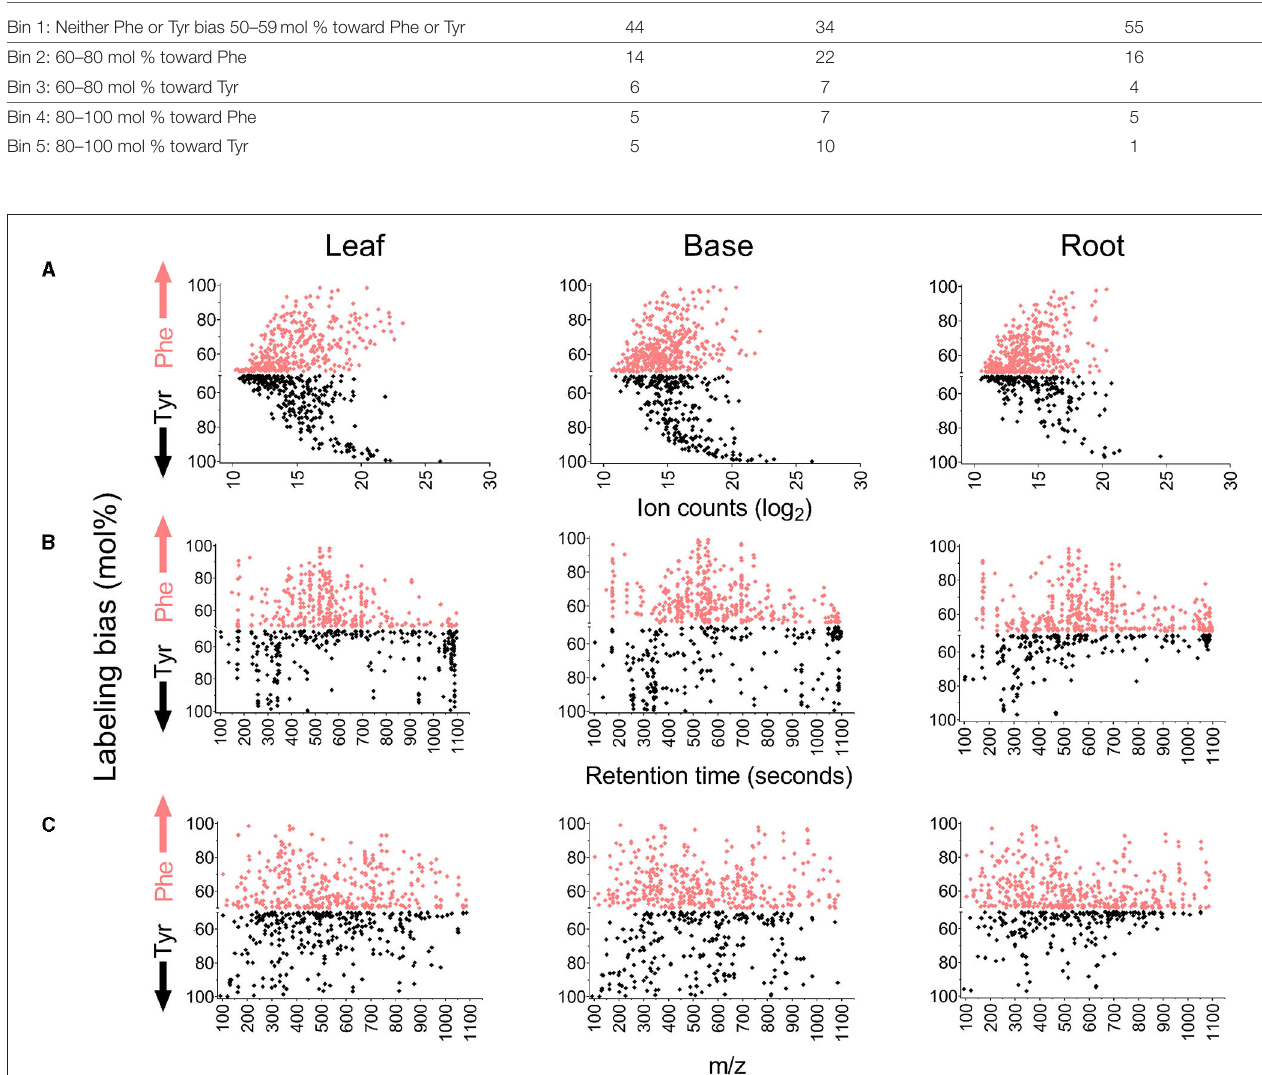
FIGURE 5 | Comparison of properties of metabolite features based on their incorporation of 13 C Phe or 13 C Tyr. The y-axis on each graph reports mol% labeling from Phe or Tyr if the bias toward an amino acid was above 50%. Features that fall above the middle axis were more heavily derived from Phe, and features that fall below were more heavily derived from Tyr. For example, an MS feature with a 90 mol% labeling from Phe and 10 mol% labelings from Tyr will be represented on the y-axis by a single point at 90 in the Phe-bias portion of the graph. On the contrary, an MS feature with a 10 mol% labeling from Phe and a 90 mol% labeling from Tyr will be represented by 90 mol% in the Tyr-bias portion of the graph. (A) Comparison of labeling bias to the ion counts in each metabolite feature ( 12 C-fed samples). (B) Comparison of labeling bias to the retention time of metabolite features. (C) Comparison of labeling bias to m/z value for metabolite